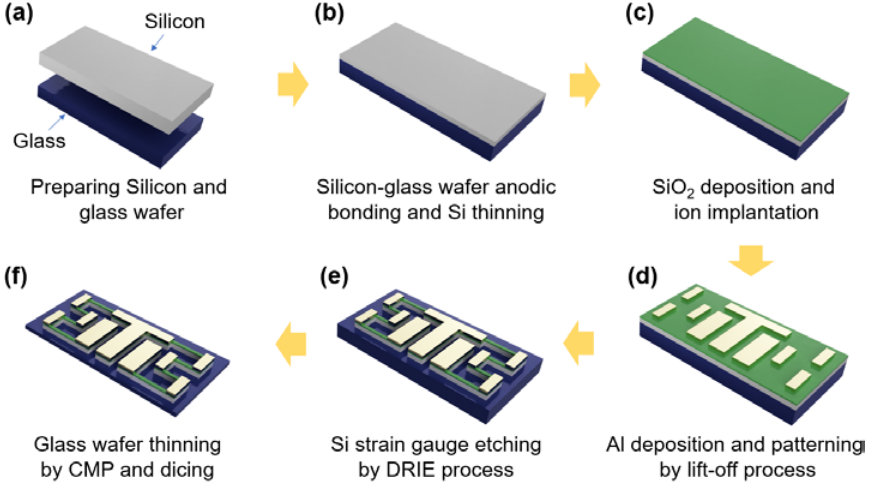
Figure 3. Fabrication process for Si strain gauge chip.